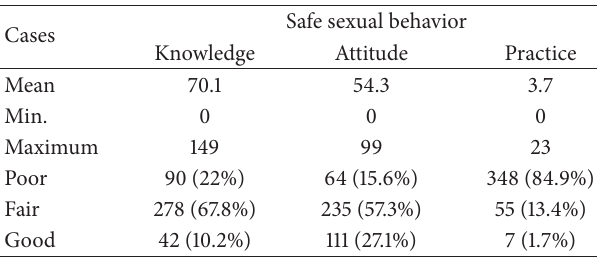
Table 3: KAP scores of sexual behavior in overall